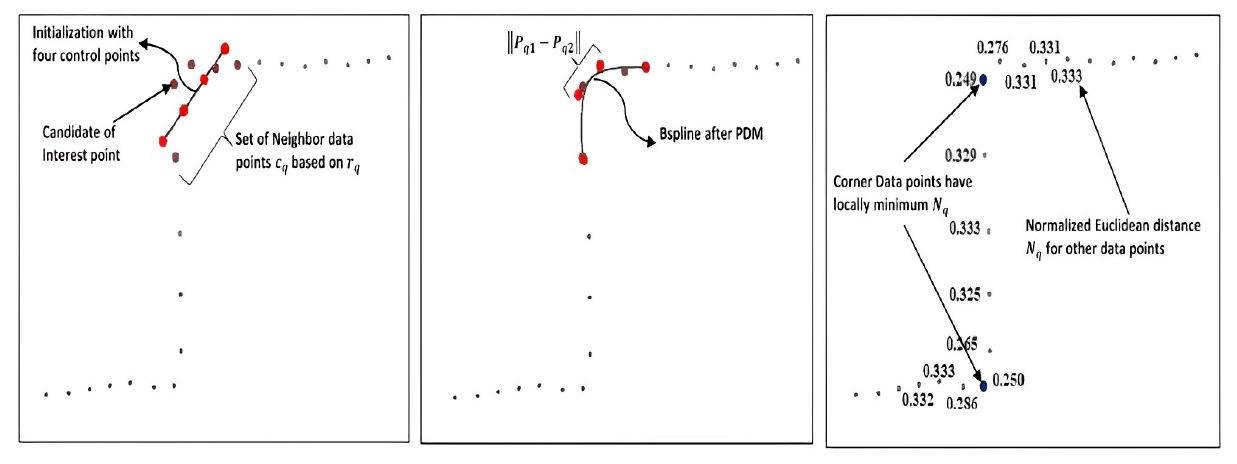
Figure 6. The B-spline-based interest point detection BID method with initialization step ( left ), PDM ( middle ) step for the corner data point, and the normalized Euclidean distance N q values (right) calculated for candidates of the interest points around the actual corner points [3]. The four control points are represented in red